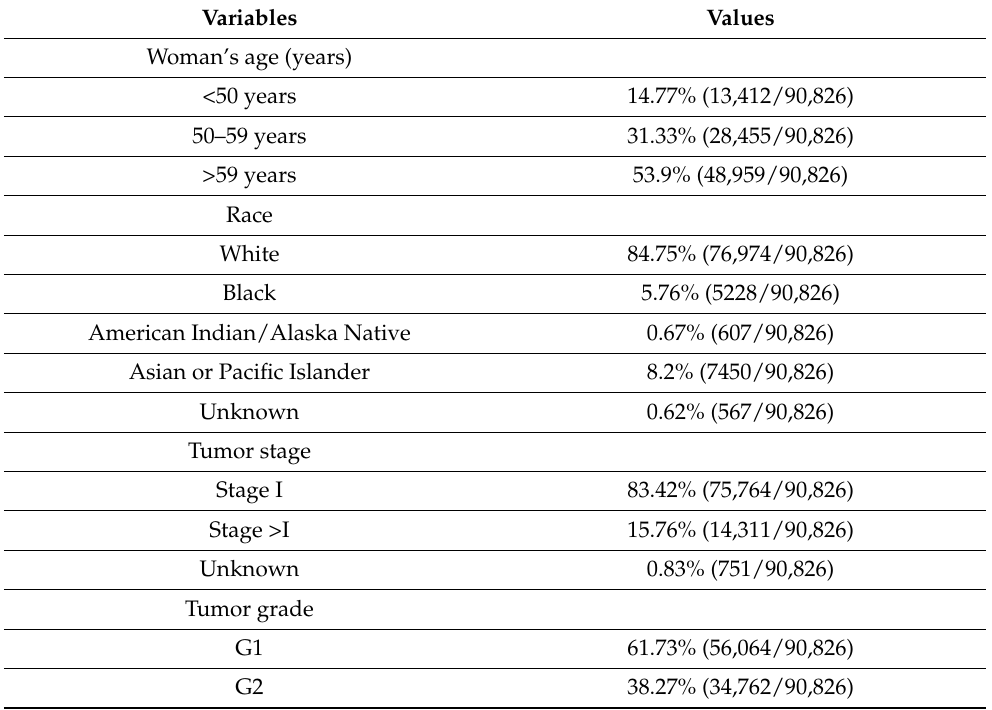
Table 1. Population